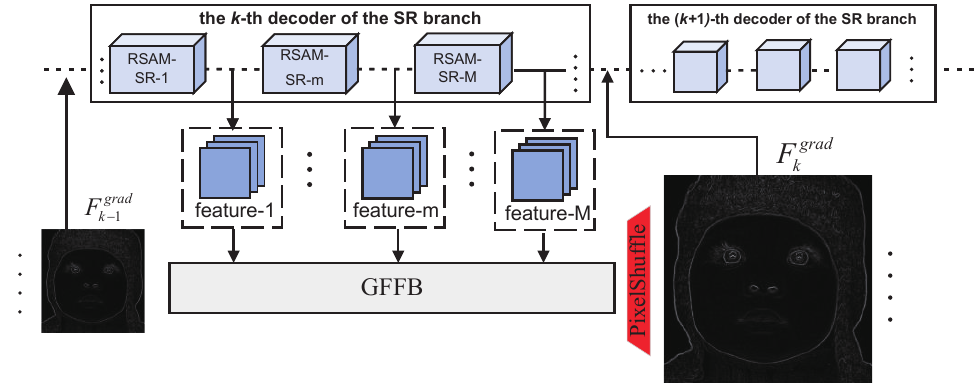
Figure 2. Architecture of the k -th gradient module of the gradient